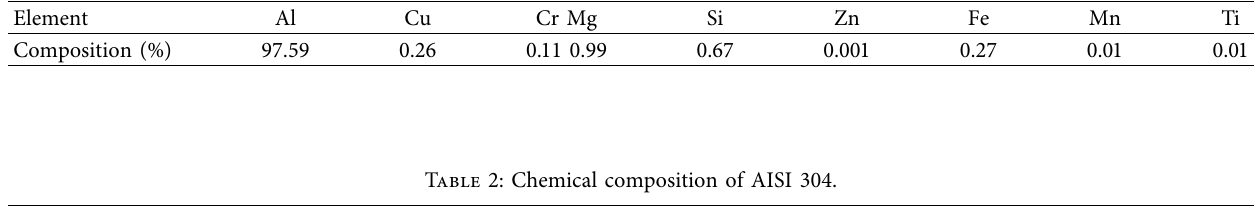
Figure 1: (a) Die sinking EDM machine. (b) EDM pulse generator and controller. Table 1: Chemical composition of Al 6061.